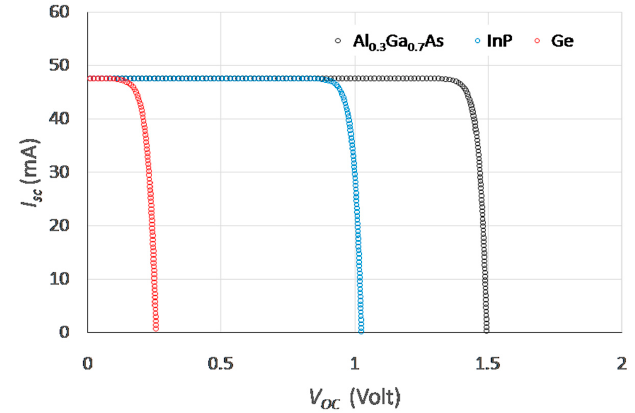
Figure 4. The electrical performance ( I-V diagram) of Al 0.3 Ga 0.7 As / InP / Ge TJSC at the geosynchronous orbit of Venus. All subcells were connected in a series connection and possess the same current.